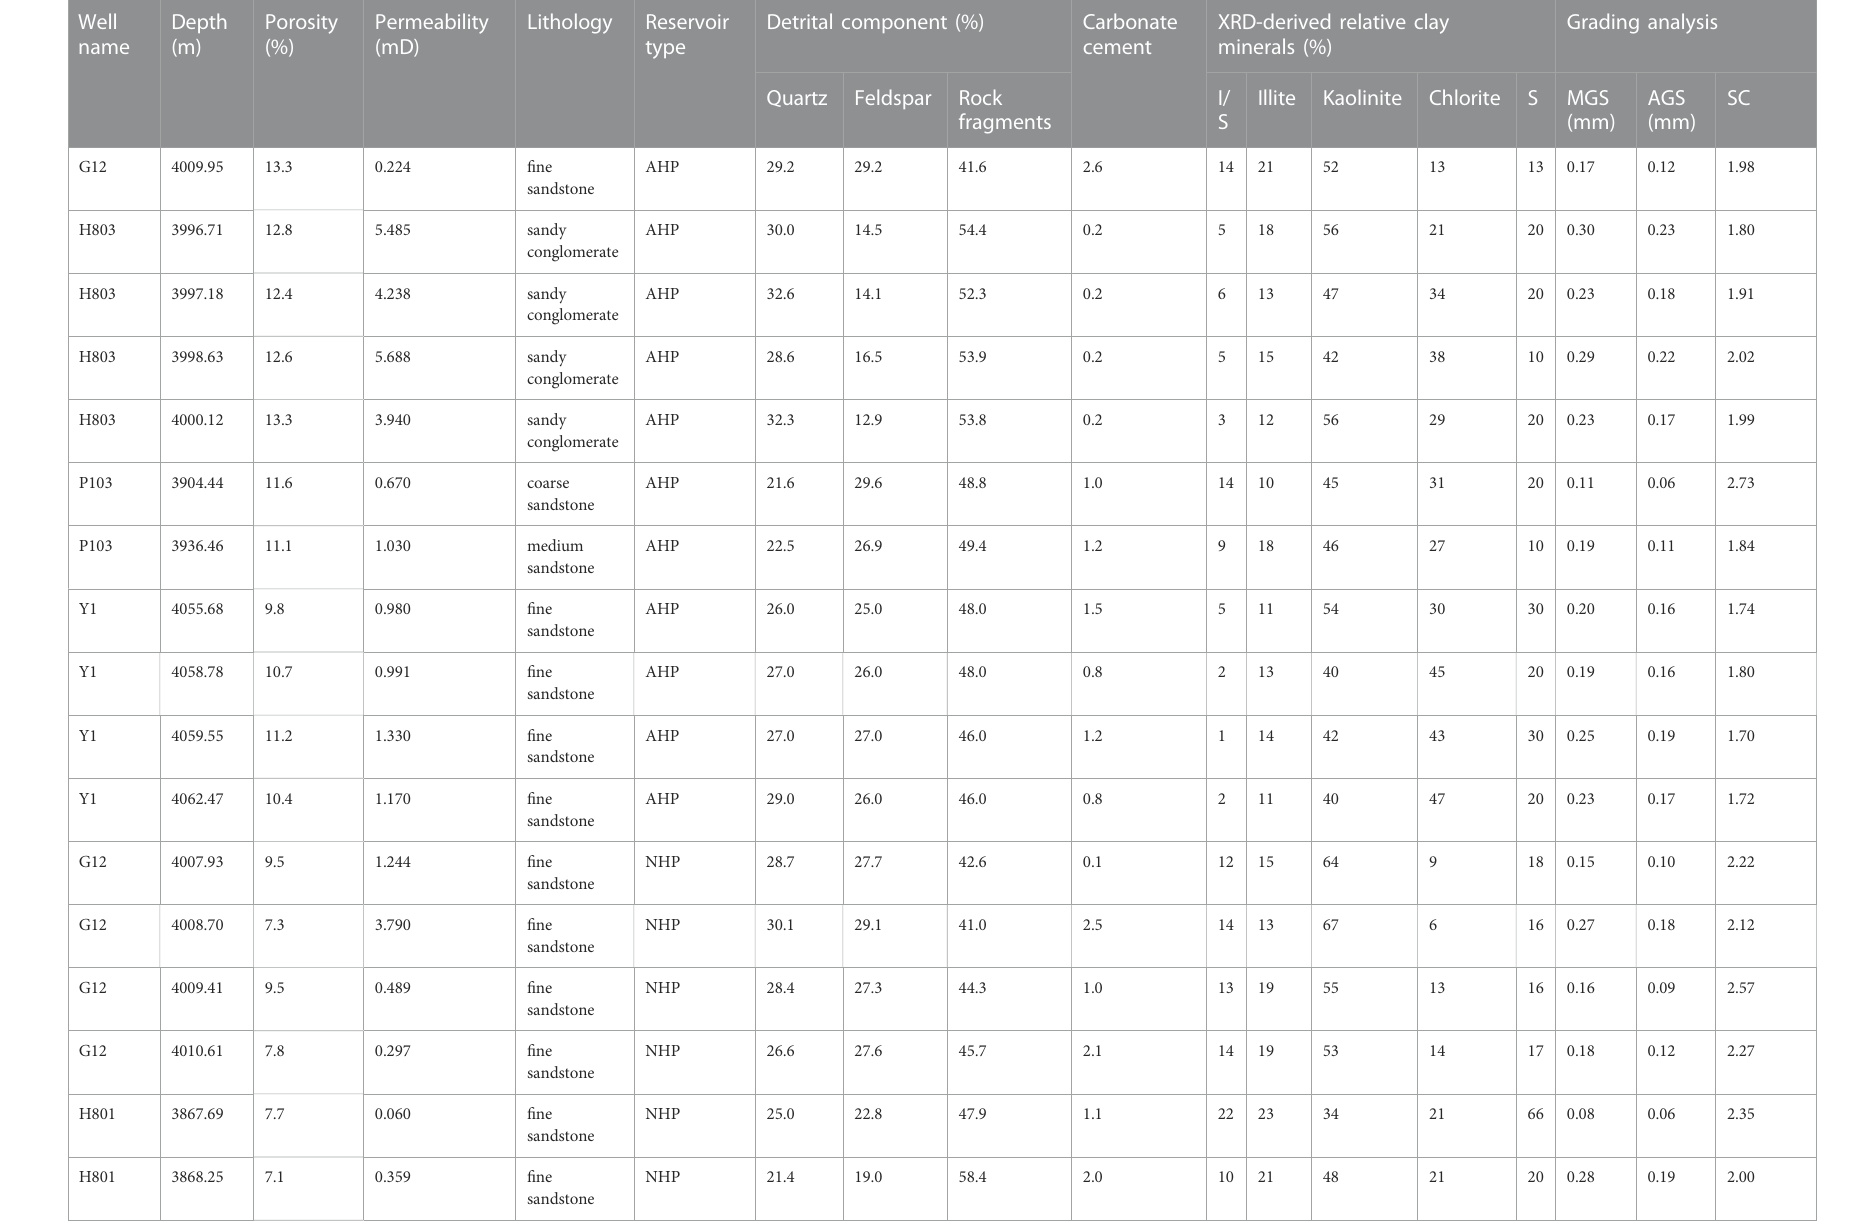
TABLE 1 The detrital components, major diagenetic minerals and grain sizes of different types of sandstone reservoirs in the Taibei sag. Well